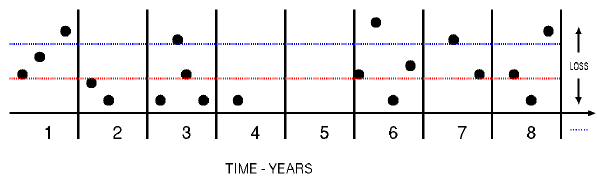
Figure 1. Above is a depiction of a simulation timeline. The dots represent event occurrences. Years are on the x axis. Loss is repre- sented on the vertical y axis. The red bar represents an “attachment point”. The blue bar represents the “exhaustion